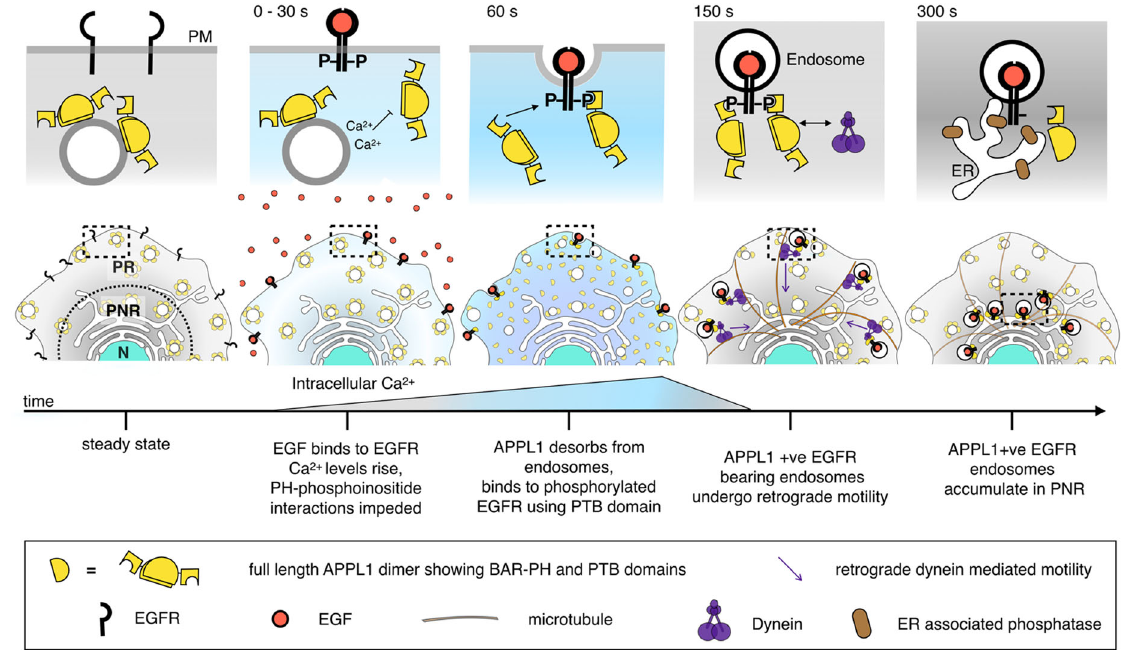
Fig. 6 Summary fi gure of proposed mechanism of APPL1-mediated shunt traf fi cking of activated EGFR. In steady-state cells, APPL1 (yellow semi- circles) is dispersed throughout the cell. EGF binding leads to dimerization and phosphorylation of EGFR and an increase in intracellular Ca 2 + (blue background). The increase in intracellular Ca 2 + impairs APPL1 PH binding to phosphoinositide causing APPL1 desorption. The increased cytosolic APPL1 results in APPL1 binding to activated EGFR via a PTB domain. APPL1 positive EGF-bearing endosomes undergo dynein (purple fi gure) mediated motility to the peri-nuclear region which is rich in